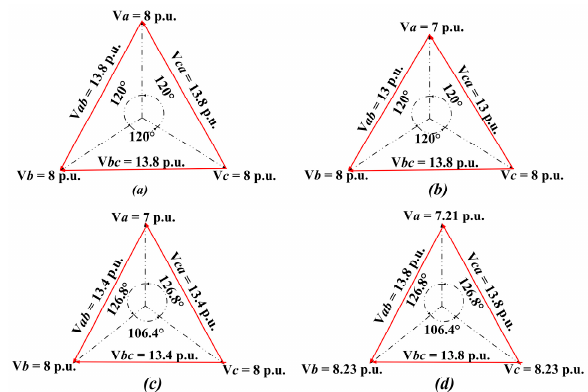
Figure 3. Fundamental phase shift compensation control block diagram, ( a ) Output voltages under normal operation; ( b ) Output voltages after one faulty cell bypassed; ( c ) Output voltages after modifying phase angles; ( d ) Output voltages after adding the fault recovery factor.